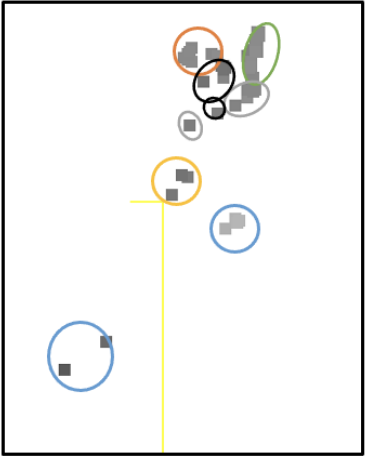
Figure 1. Quantitative alignment annotation visualized as histograms: ( a ) C gene superfamily; ( b ) G2 gene superfamily; and ( c ) O1 gene superfamily. Bright yellow and light gray indicate high scores.